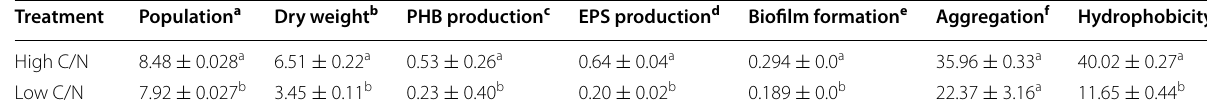
a log CFU ml − 1 b